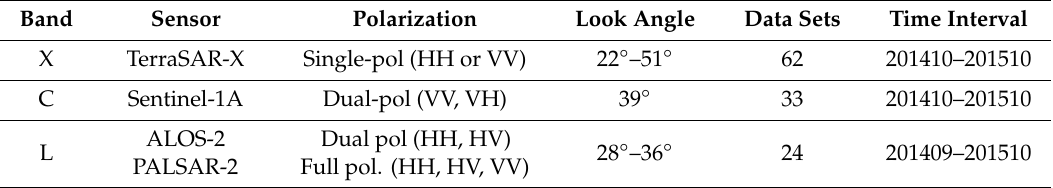
Table 1. Synthetic Aperture Radar (SAR) dataset covering the test site of Remningstorp.